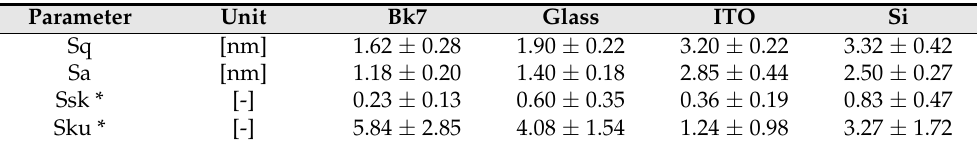
Table 3. Surface parameters of Cr films deposited on BK7, Si, and glass substrates, according to ISO 25178-2:2012. The average results were expressed as mean values and standard deviation. Parameter Unit Bk7 Glass ITO Si Sq [nm] 1.62 ± 0.28 Sa